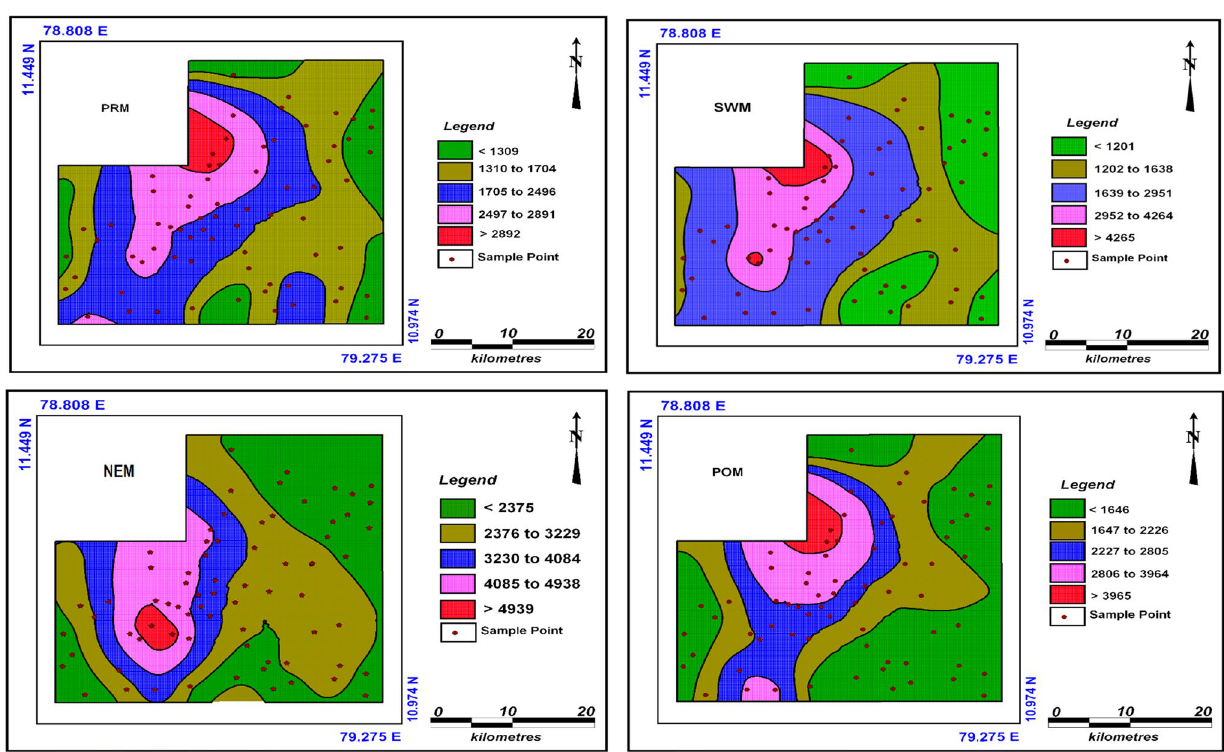
Fig. 3 The temporal variation of Electrical conductivity in the groundwater samples and their spatial distribution (all values in µs/cm)